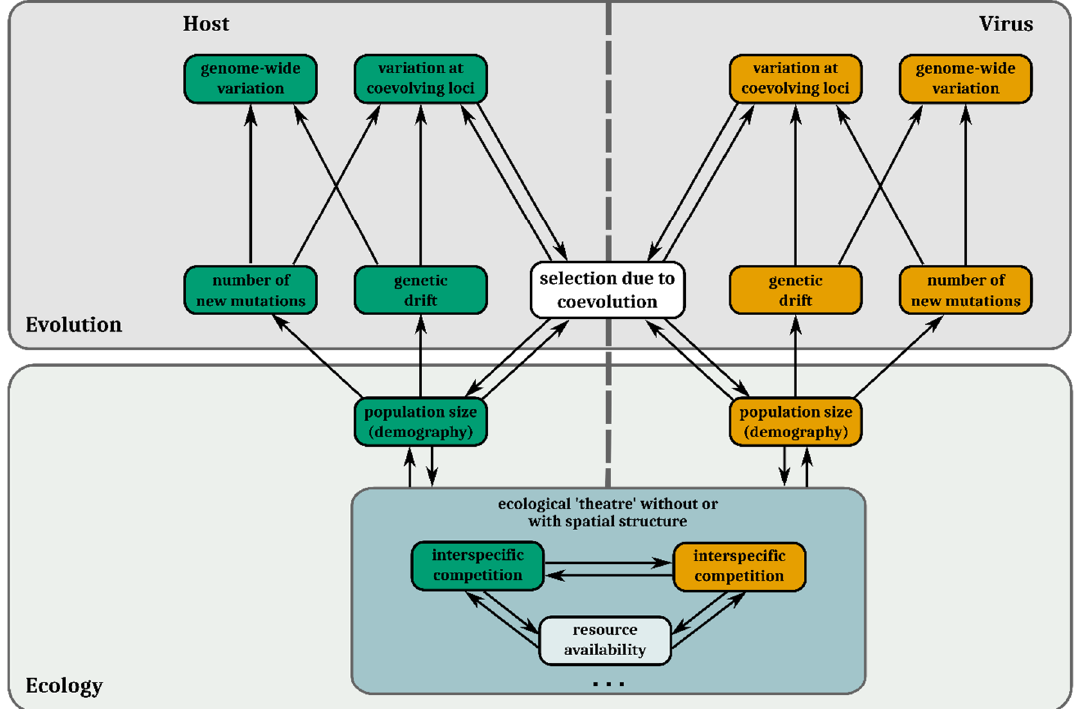
Figure 3. Potential interactions between ecological processes and evolutionary processes in host–virus coevolution and how they interact with and shape genomic variation. In the evolution section, boxes in the top row correspond to genomic variation and those in the second row (bottom) to evolutionary forces governing them. Eco-evolutionary feedback loops take place when coevolutionary selection alters population sizes and/or other ecological processes (third row and below), which in turn alters how the different genomic forces affect genomic variation. The dots at the bottom indicate that the above-mentioned ecological processes by no means constitute an exhaustive list. Features of the host are always presented in green and features of the virus in orange. Selection imposed by abiotic variables is not included in this figure.